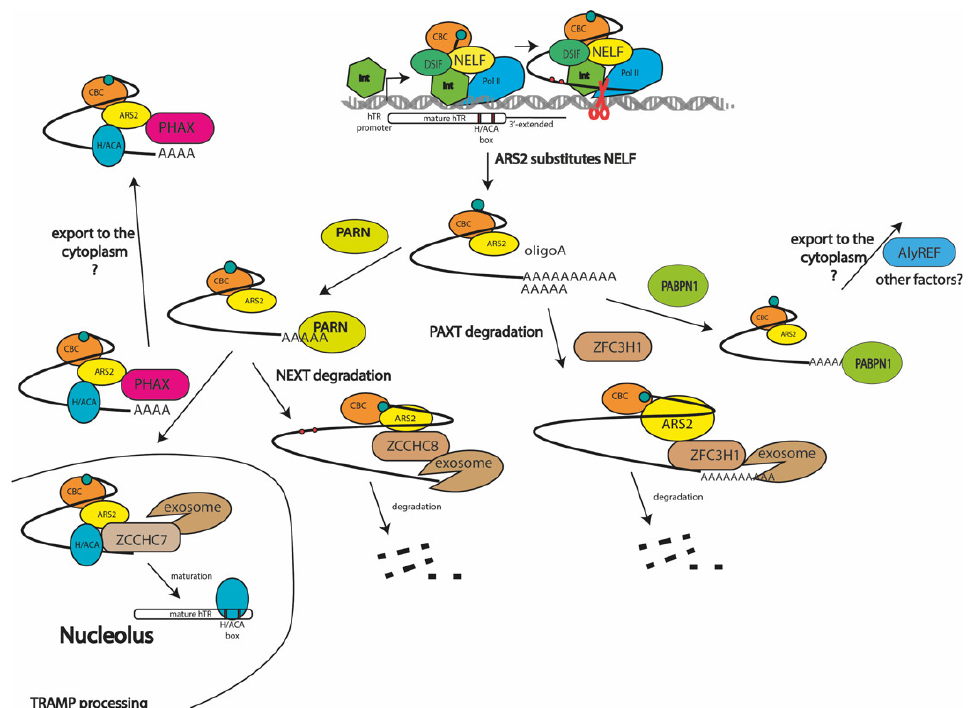
Figure 5. Scheme illustrating hTR processing and turnover pathways.